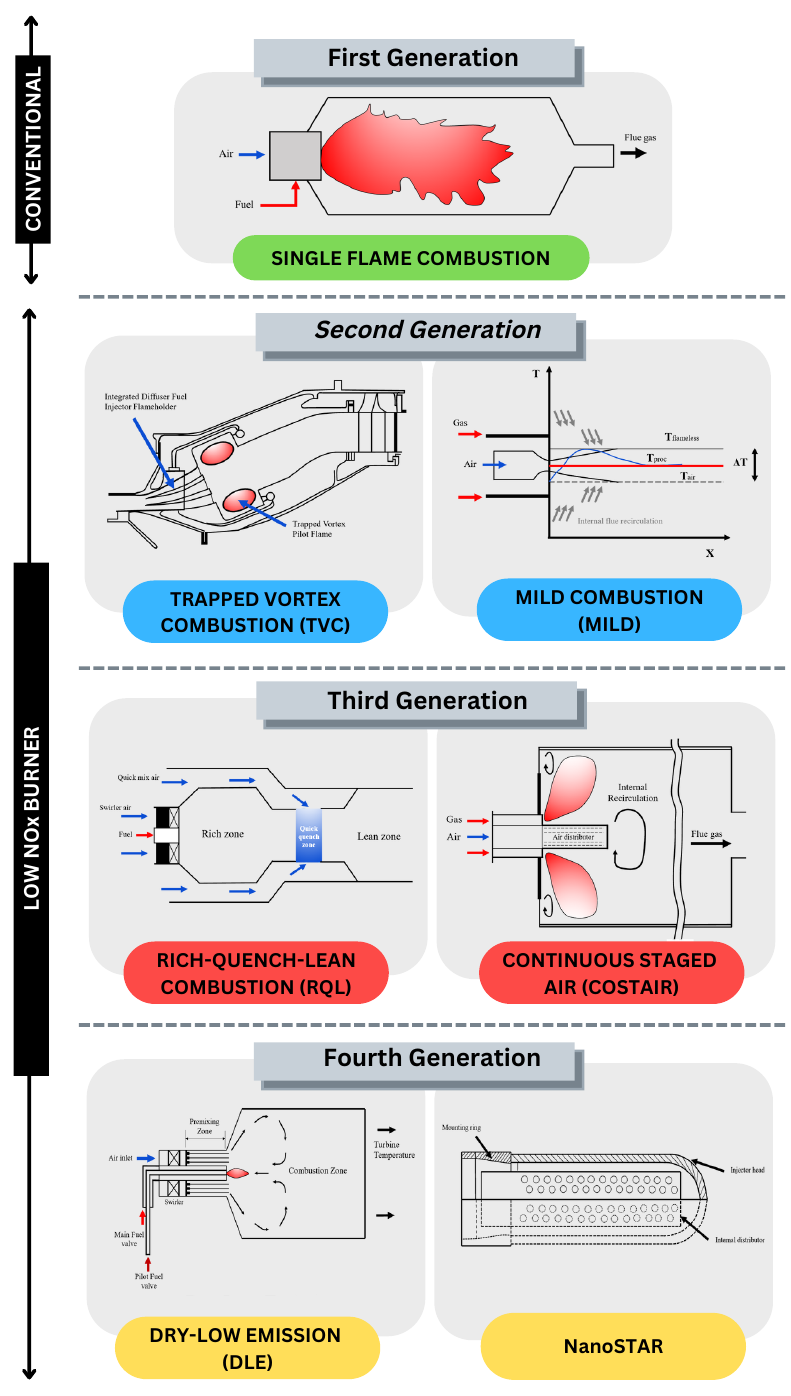
Figure 5. Evolution of gas turbine combustion